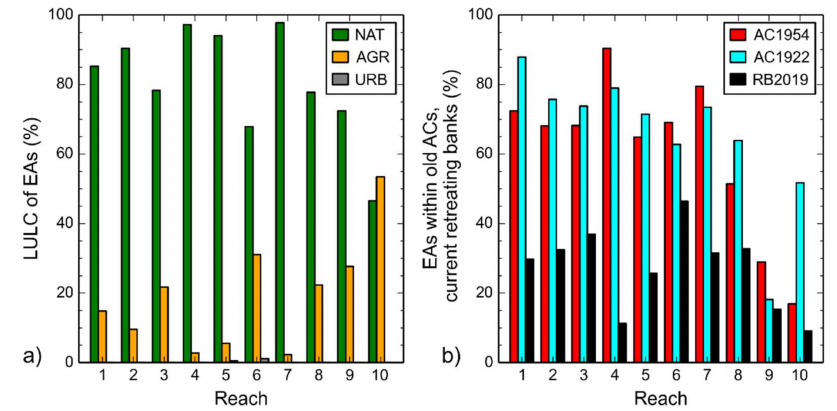
Figure 8. ( a ) 1999 LULC percentage area of 1999-2019 EAs at reach scale; NAT, seminatural area; AGR, agricultural area; URB, urban area; ( b ) Percentage of EAs belonging to the 1922 (AC1922) and 1954 (AC1954) active channel, and percentage length of the present-day retreating banks